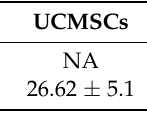
Figure 1. Intracellular uptake and cytotoxicity of curcumin and curcumin PM in stromal cells and MCF7 cells in a two-dimensional culture. ( A ) The internalization of curcumin molecules was observed in curcumin PM–treated cells but not in curcumin-treated ones after 30 min and 1 h of incubation at 30 µ g/mL. ( B ) The cell viability (%) of stromal cells and MCF7 cells treated with curcumin and curcumin PM. The data are presented as mean ± SD, N = 3. Scale bar: 10 µ m.